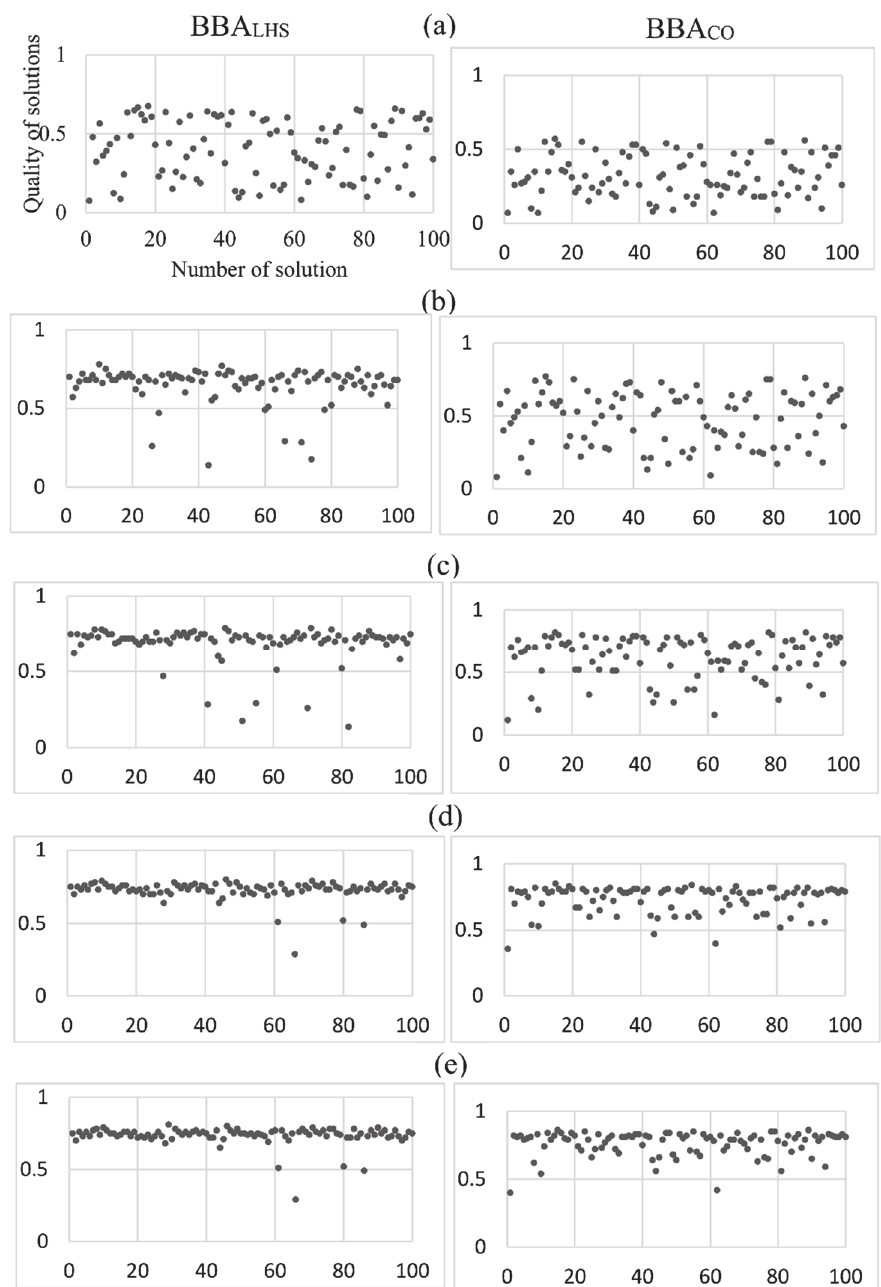
Figure 7. Diversity of solutions in ( a ) first generation, ( b ) generation 20, ( c ) generation 50, ( d ) generation 80 and ( e ) generation 100, using BBA LHS (left) and BBA CO (right) for WebKB dataset.